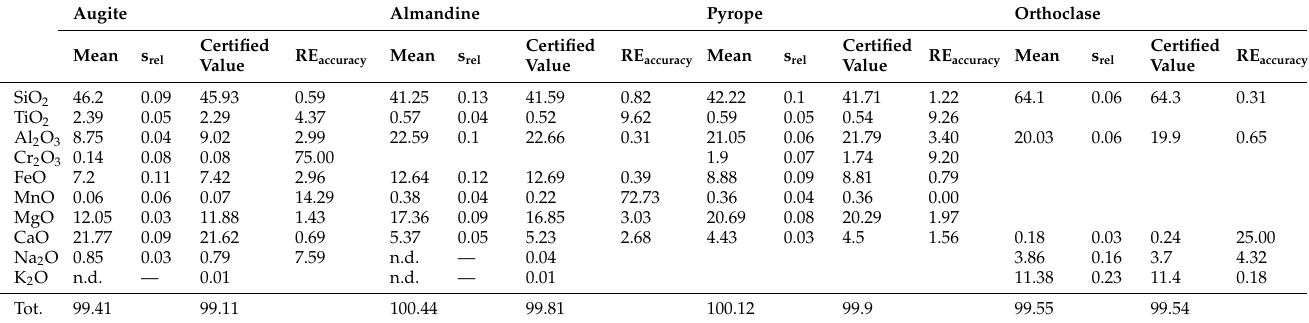
Table 5. SEM-EDS precision and accuracy. Mean of 10 microanalyses on four reference standards (augite, almandine, pyrope and orthoclase) with the relative standard deviation ( σ rel ), certified values from Micro-Analysis Consultants Ltd. (U.K.) and relative error (RE accuracy ). n.d. = not detected.